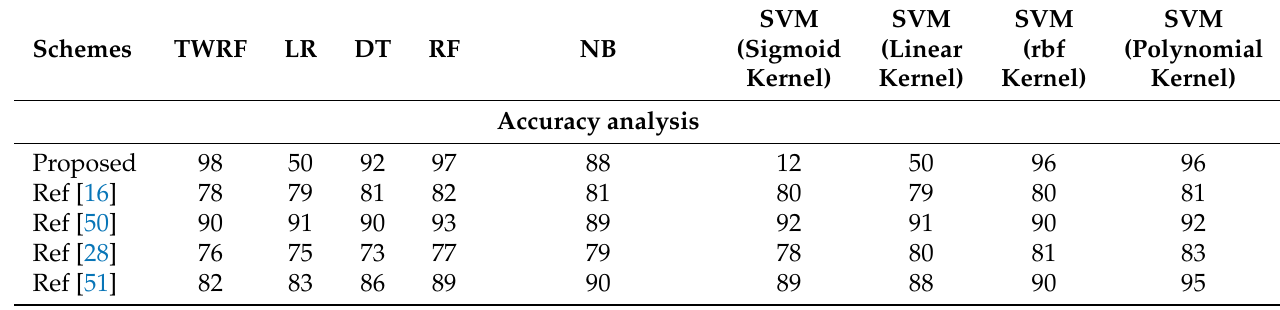
Table 7. Performance comparison of the proposed work with the existing